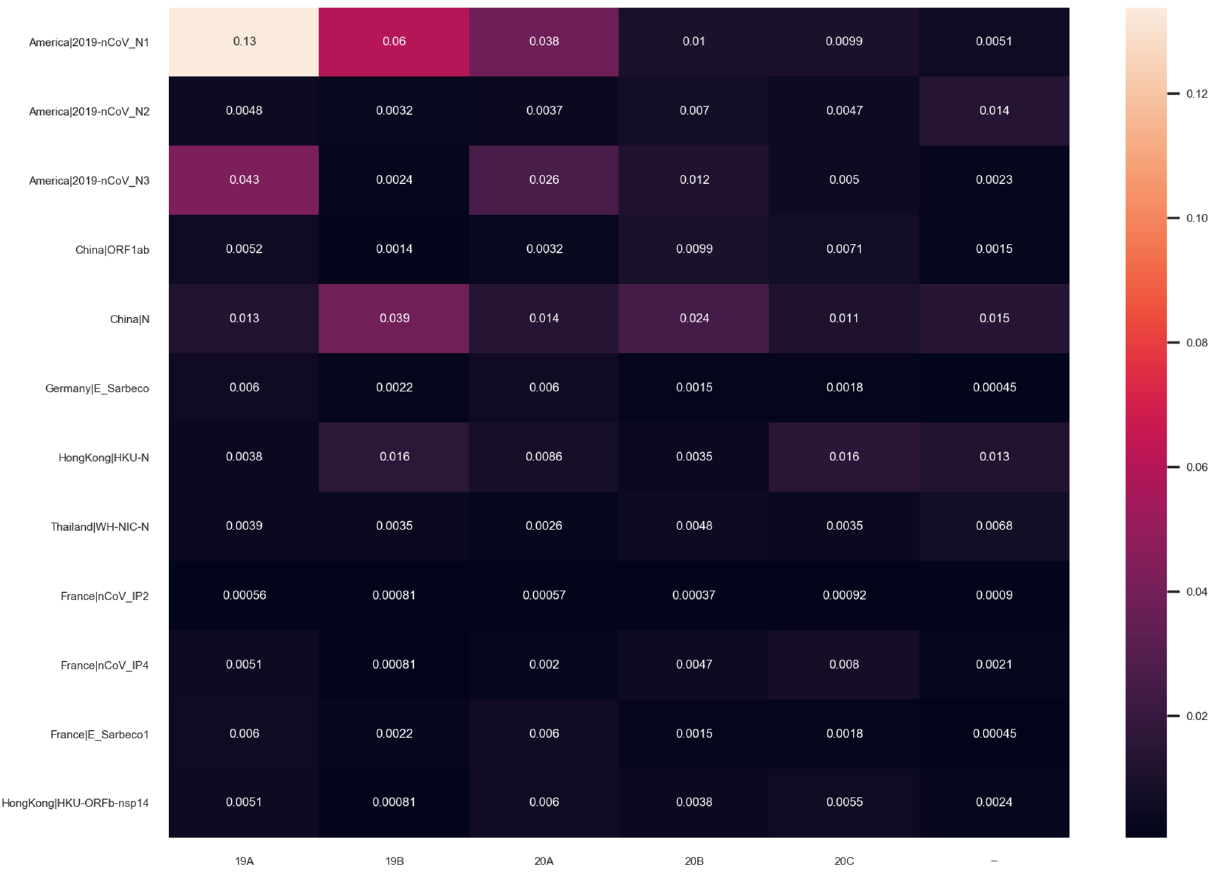
Figure 7. Average number of mutations for each PCR test that occur within each clade, as defined by